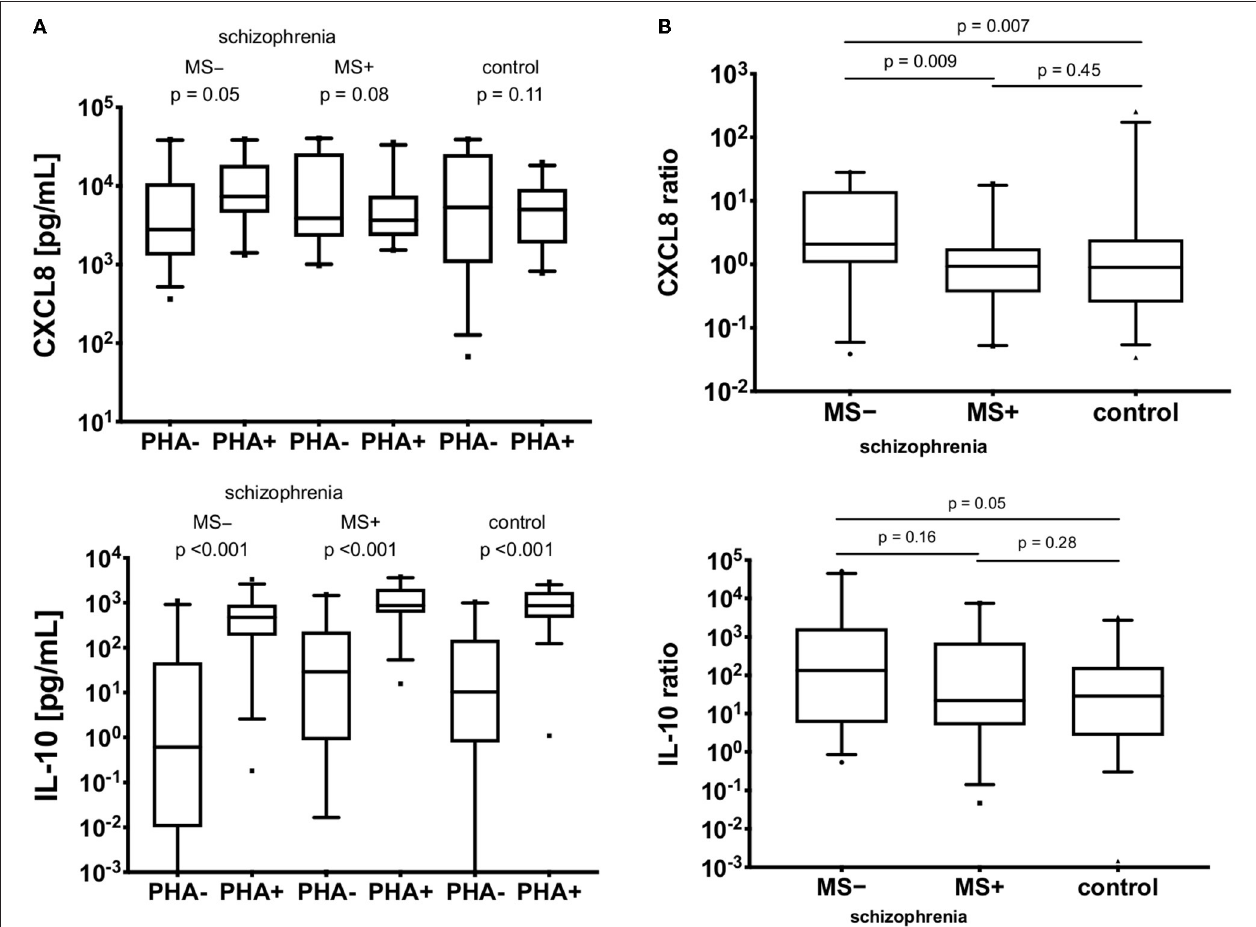
FIGURE 4 | (A) In vitro CXCL8 and IL-10 production in non-PHA (PHA–) and PHA-stimulated (PHA + ) PBMCs. MS − , patients on mood-stabilizers; MS + , patients without stabilizers. Vertical lines represent 95% CI, black boxes represent means. (B) Ratios of in vitro CXCL8 and IL-10 production in non-PHA (PHA–) and PHA-stimulated (PHA + ) PBMCs. MS − , patients on mood-stabilizers; MS + , patients without stabilizers. The boxes extend from 25 to 75th percentiles, the lines in the middle of the boxes represent medians. The whiskers extend from 10 to 90th